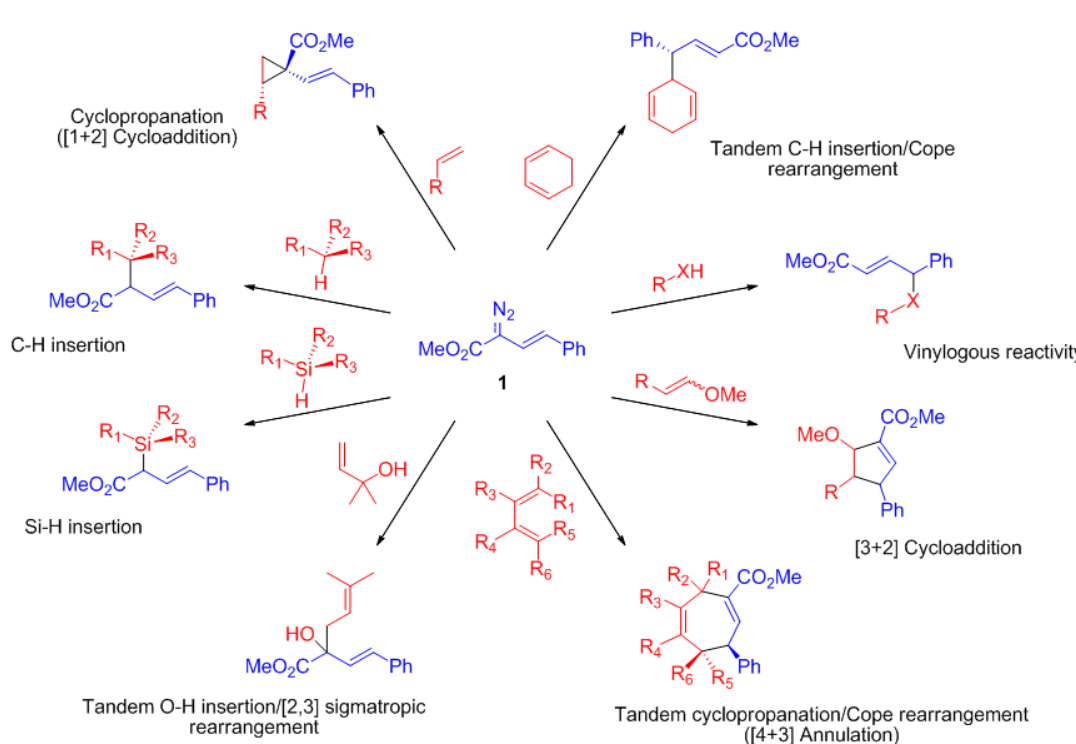
Scheme 1. Dirhodium(II)-mediated chemistry of methyl styryldiazoacetate (1) with different substrates.